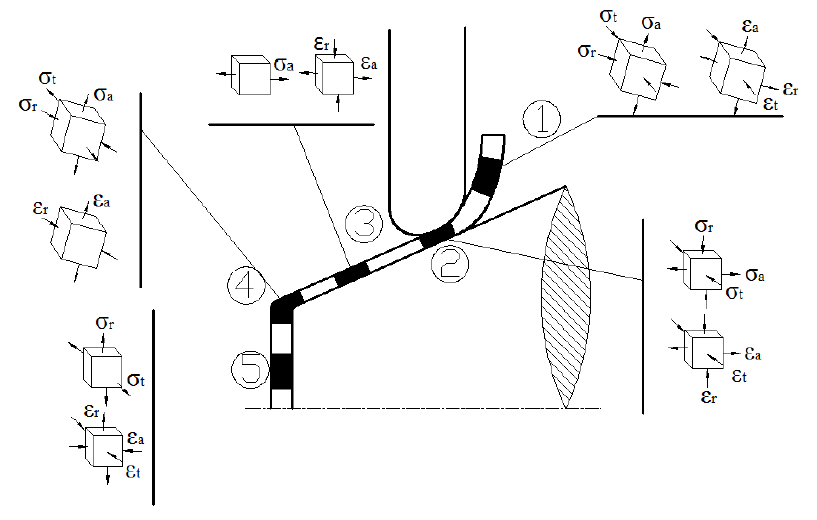
Figure 5. Mechanical model of shear spinning.